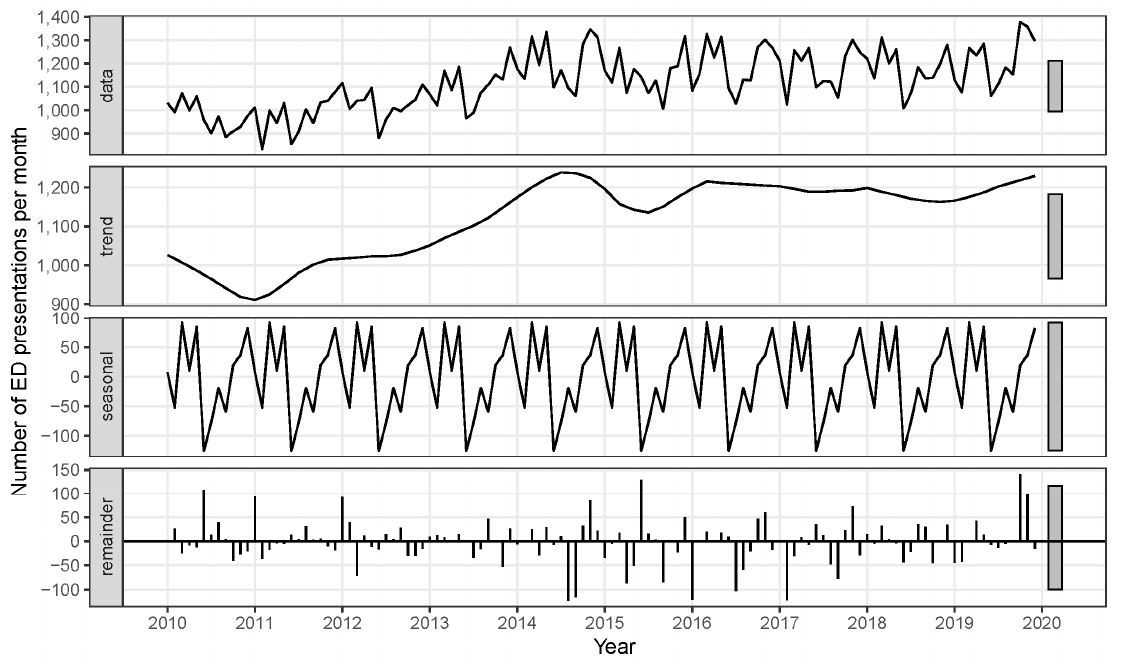
Figure 4. Seasonal and trend decomposition of paediatric injury-related ED presentation data.